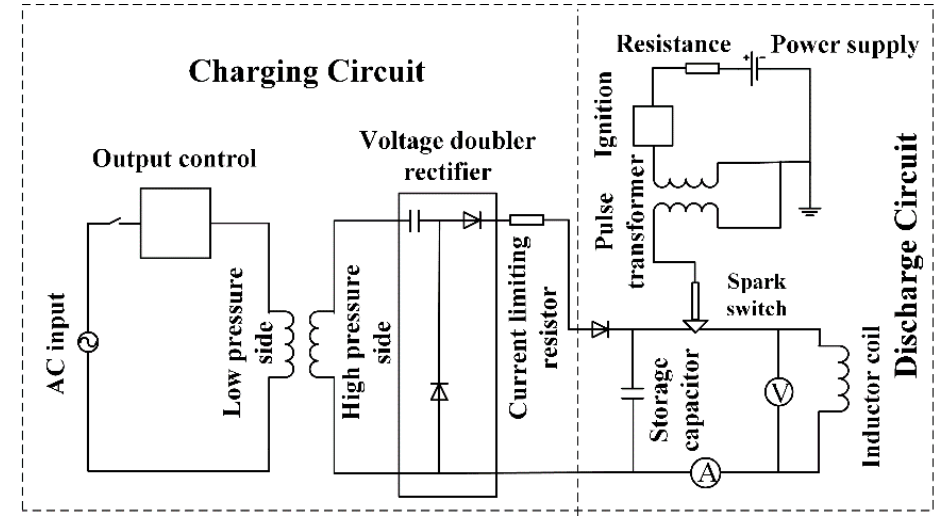
Figure 7. High-energy pulse power supply schematic.